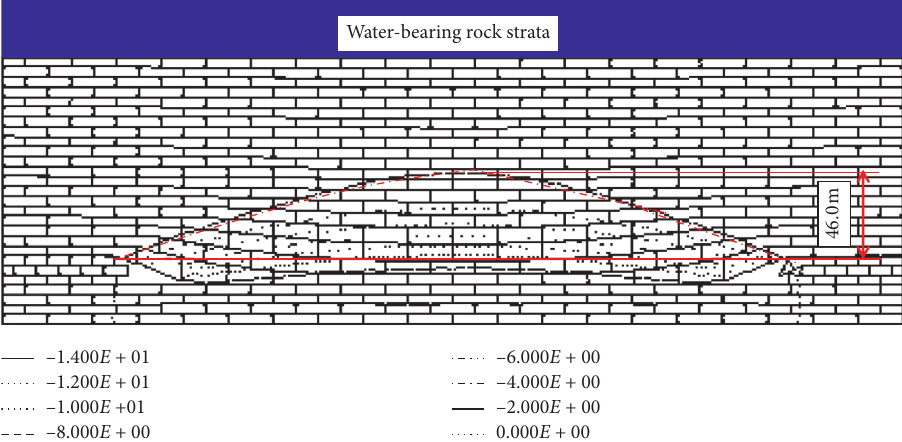
Figure 9: Caving and displacement evolution trend of overlying strata in the upper group coal